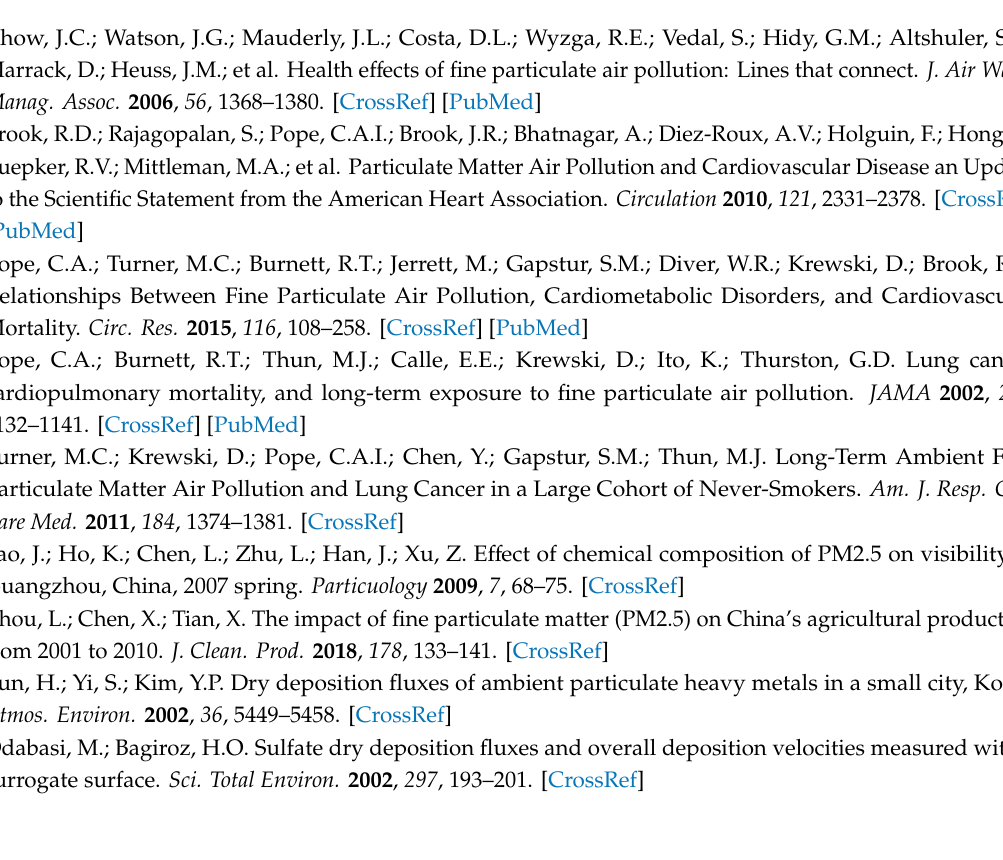
Table S1: Location of 11 national air monitoring stations in Shenzhen City and their land-use types; Table S2: GF-1 WFV images of Shenzhen City used in this study; Table S3: Results comparison of similar studies in the same or neighboring